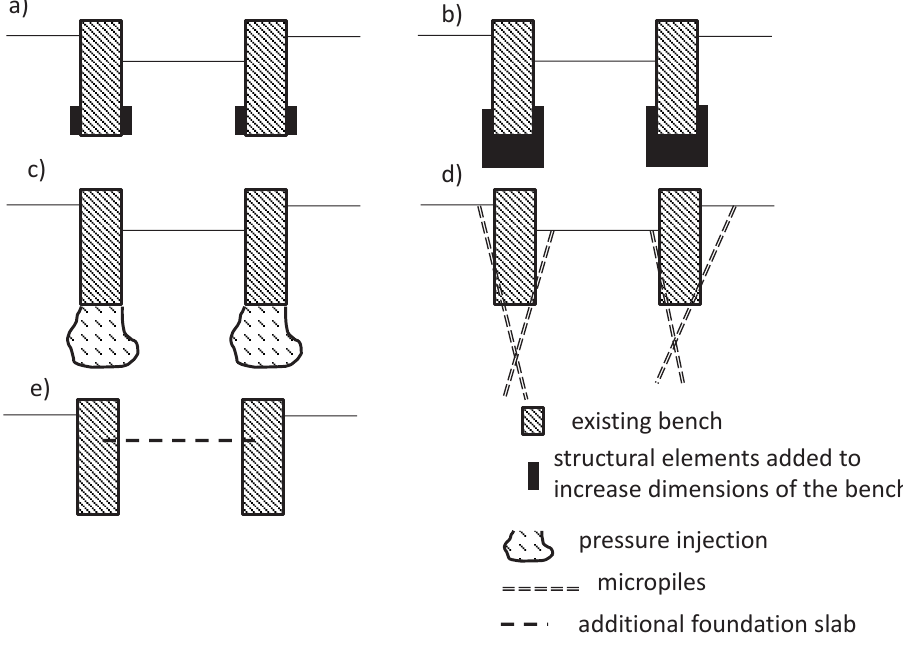
Figure 3: Remedies used to increase the load capacity of the existing foundation: increase of the existing foundation dimension: a) horizontal, b) horizontal and vertical, c) pressure injection, d) micropiles installation, e) addition of the reinforced concrete foundation